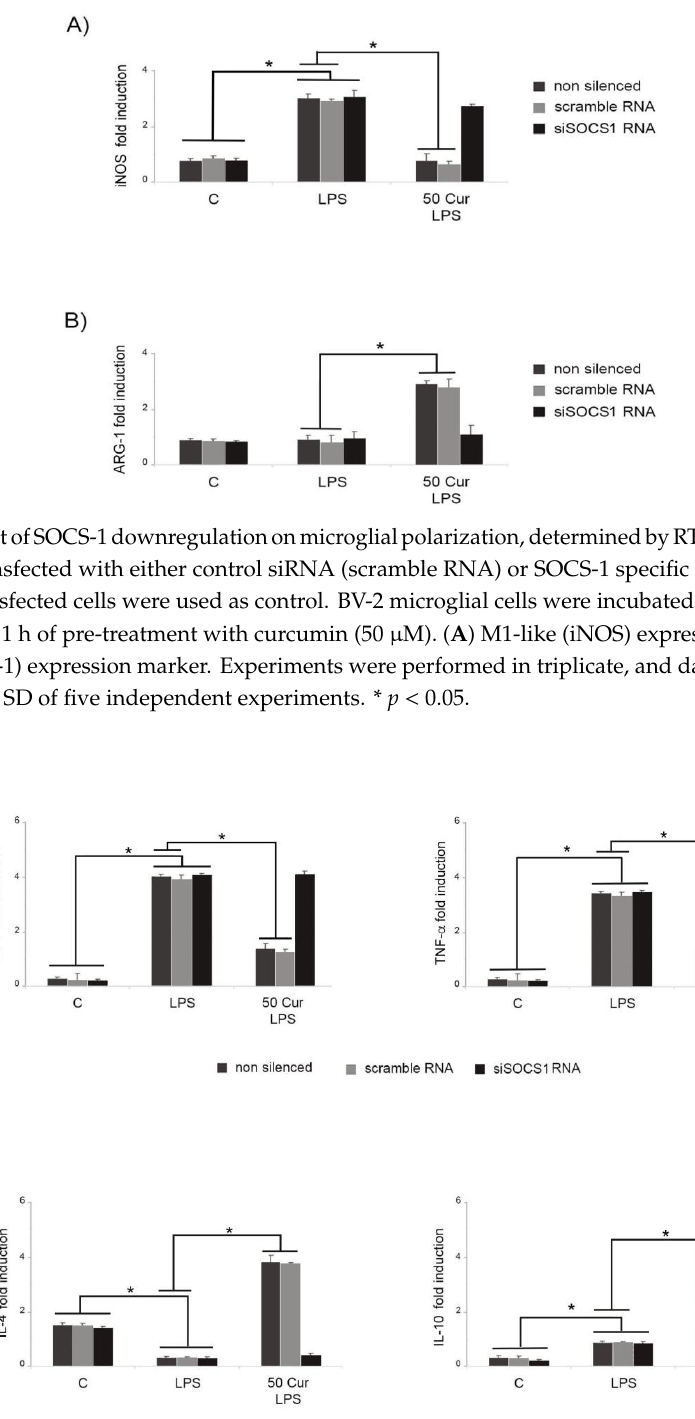
7 of 13 Figure 3. Effects of SOCS-1 silencing on JAK2/STAT3 activation in BV-2 cells. Microglial cells were